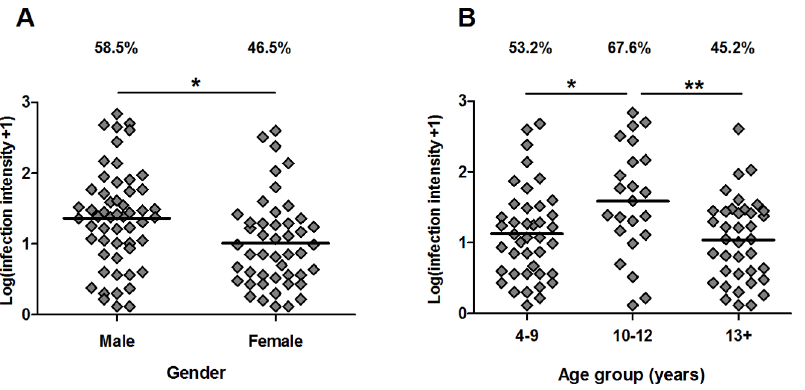
Figure 1. Distribution of S.haematobium infection in the study cohort. Infection prevalence (%) and intensity (Log10(x + 1) transformed mean egg counts/10 ml urine) sub-divided by gender ( A ) and age group ( B ). Mean values are indicated by horizontal bars. Significance levels from ANOVA (adjusted sums of squares) of infection intensity for infected participants are shown for gender and post-hoc pair-wise Fisher’s least significant difference comparisons are shown for the 3 age groups (n=101);*p , 0.005, **p , 0.01.